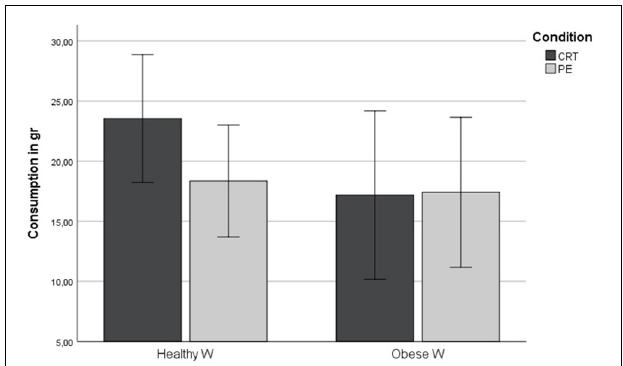
FIGURE 1 | Mean consumption in the taste